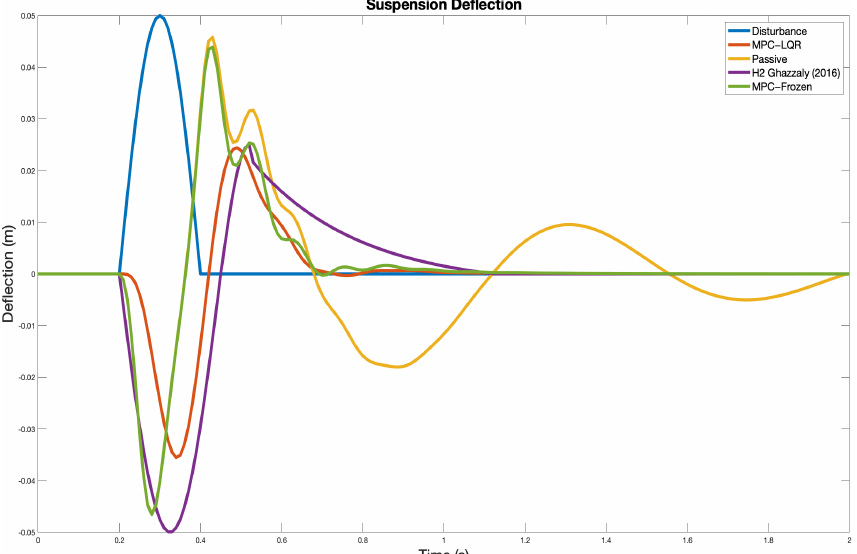
Figure 8. Suspension Deflection—Bump Disturbance (Blue—disturbance, Red—MPC-LQR, Yellow— Passive, Purple—H2,